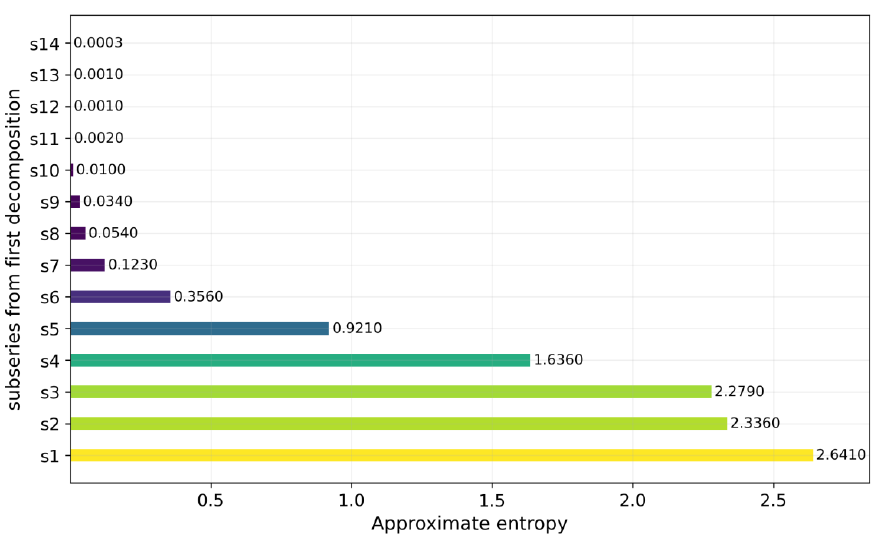
Figure 17. Box_Ljung value of each lag order. When the residual correction part was finished, the final point prediction result was generated. The process above is described in Figure 18.